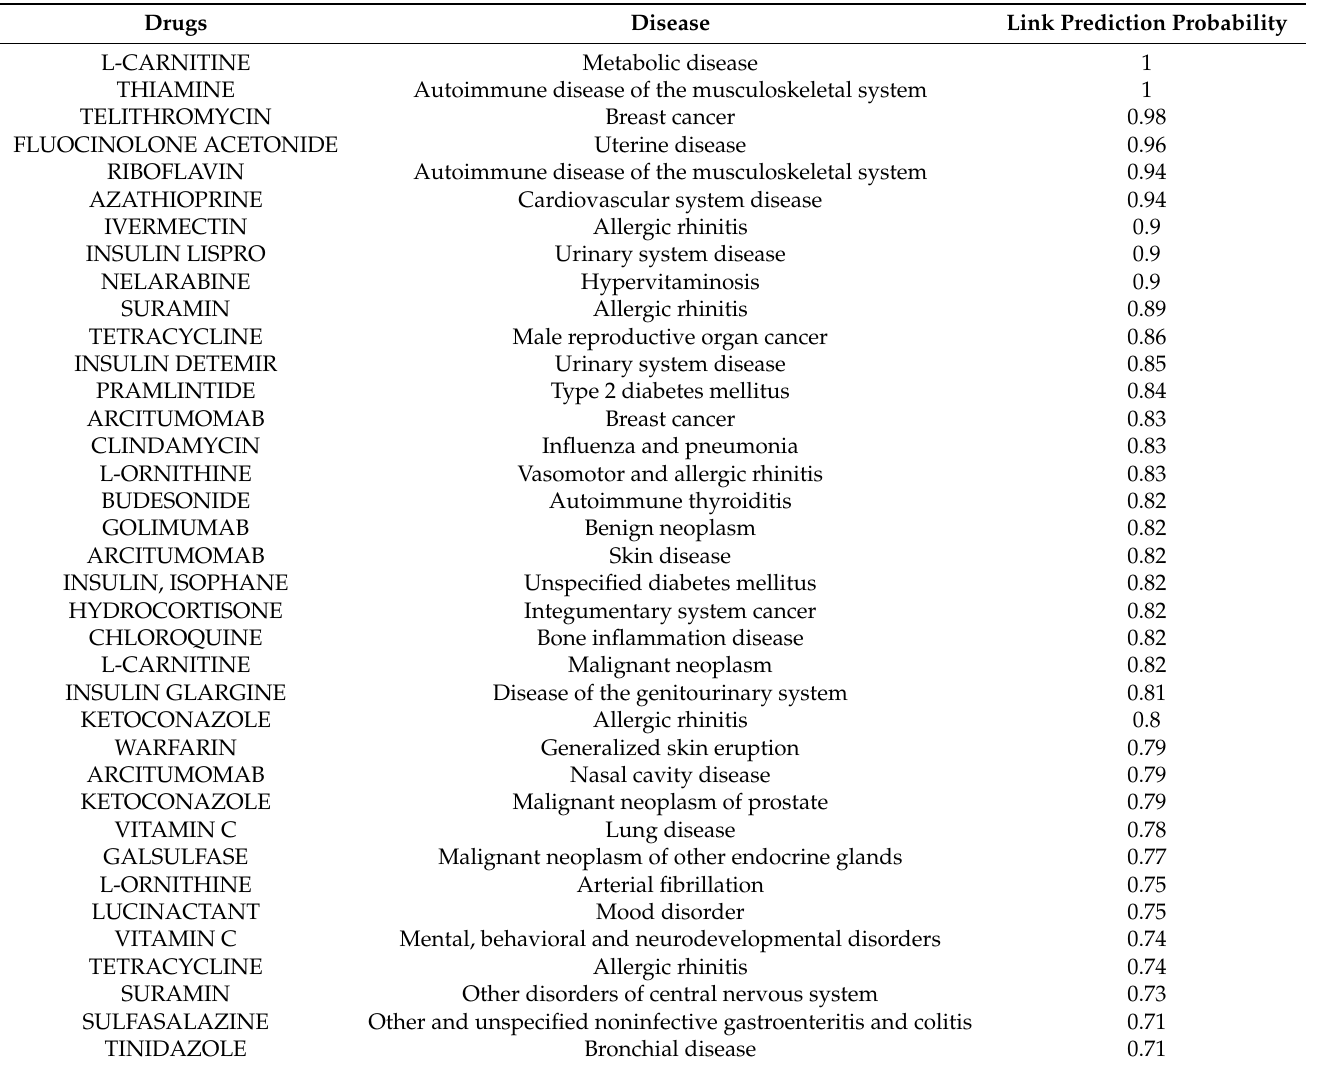
Table 3. Ranking of drugs and diseases with new predicted links using